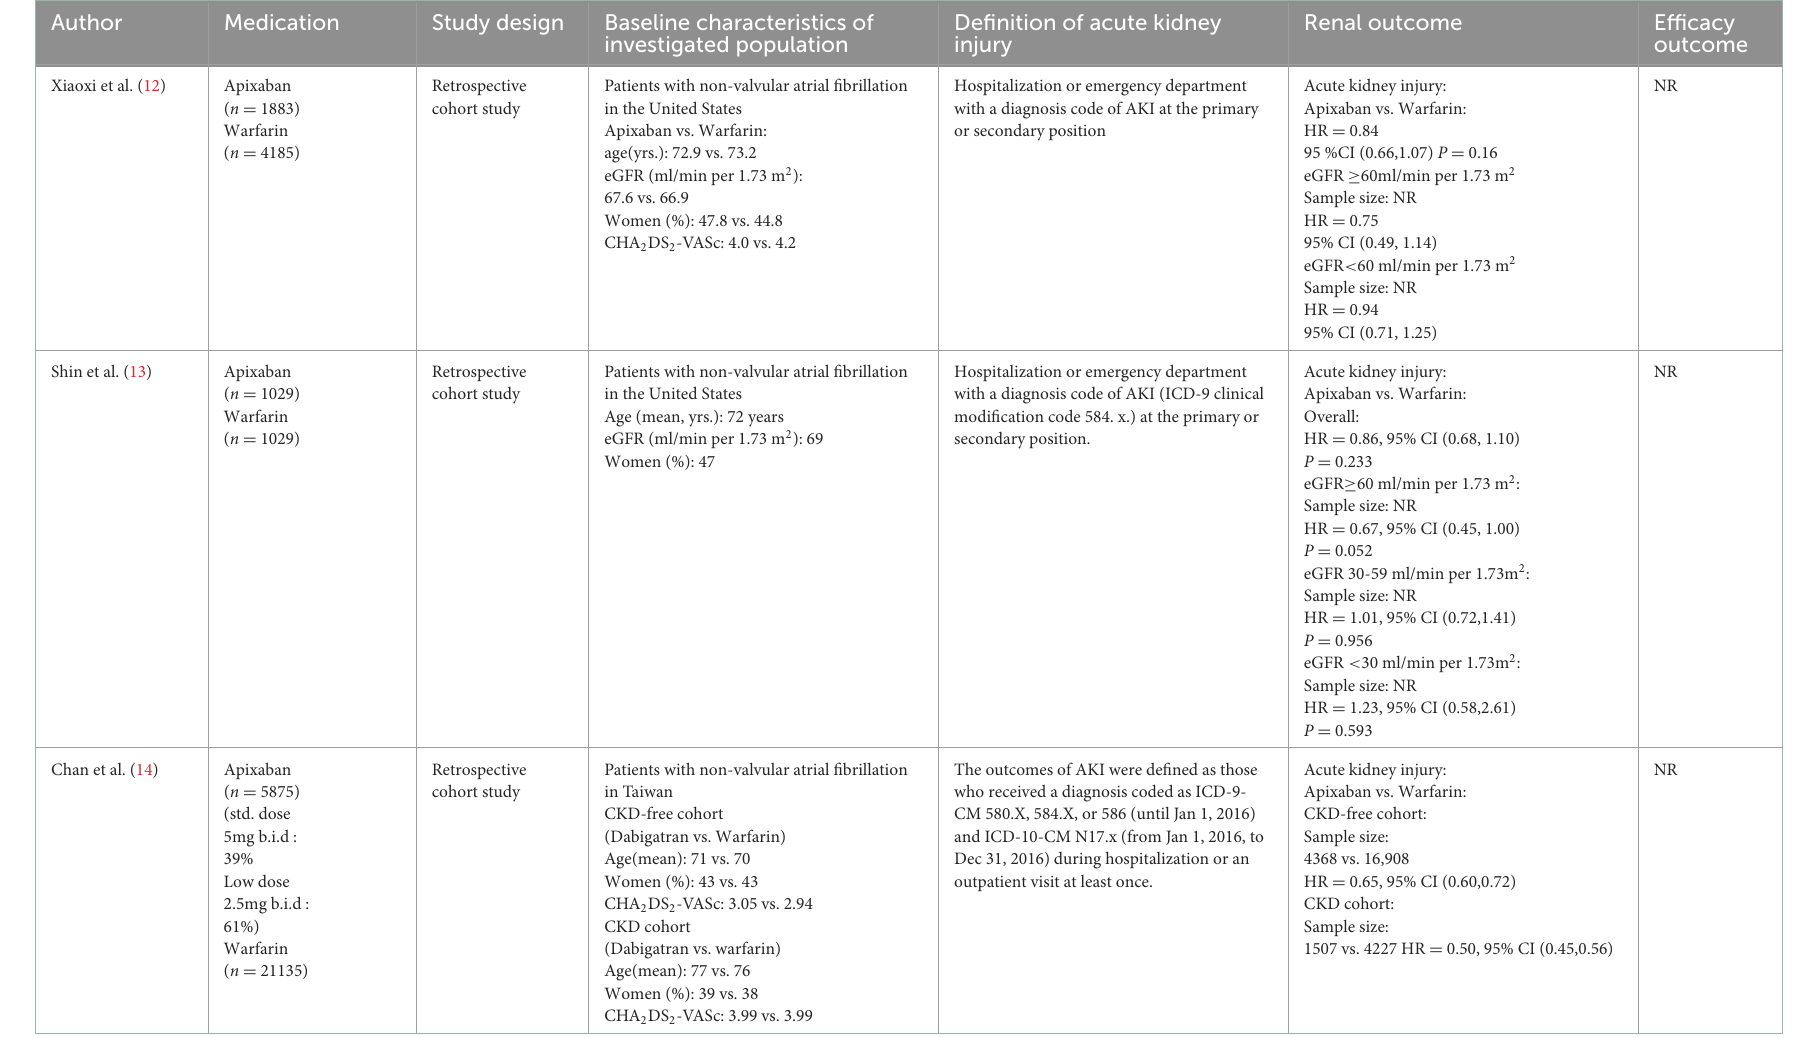
TABLE 1 Summary of studies comparing the risk of AKI induced by apixaban and